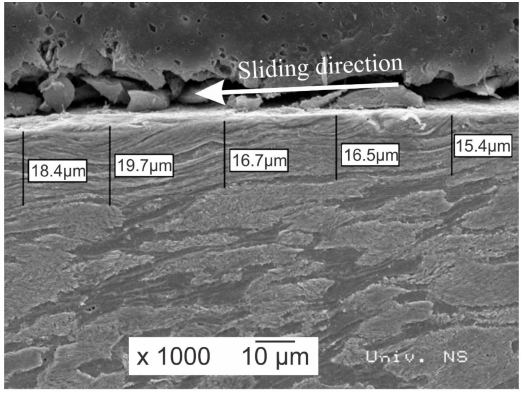
Figure 4. Illustration of the method used to determine the thickness of the layer of severe plastic deformation near friction surfaces.